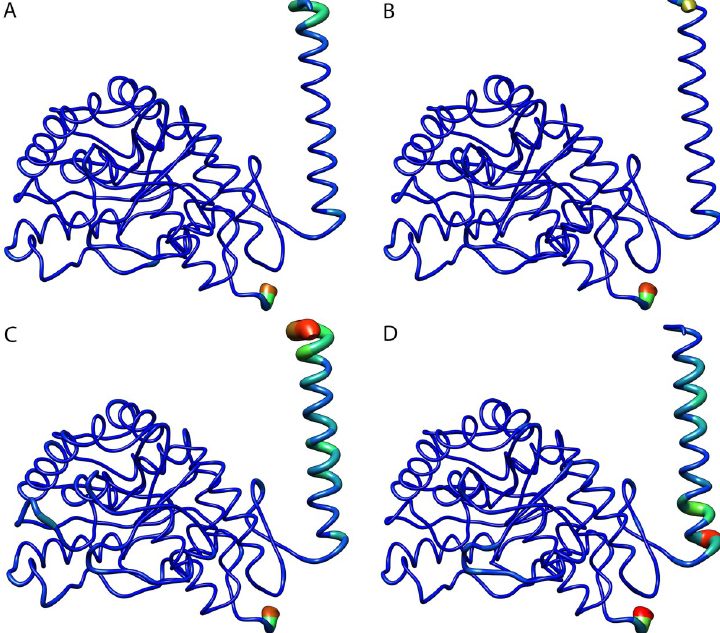
Fig 6. B-factor per residue of WT TPH2 and its variants. Each residue of TPH WT (A) and variants P206S (B), R303W (C), and R441H (D) is colored and sized according to its B-factor. The coloring-thickness scale varies from dark blue and thin (highly rigid residues) to red and thick (highly flexible